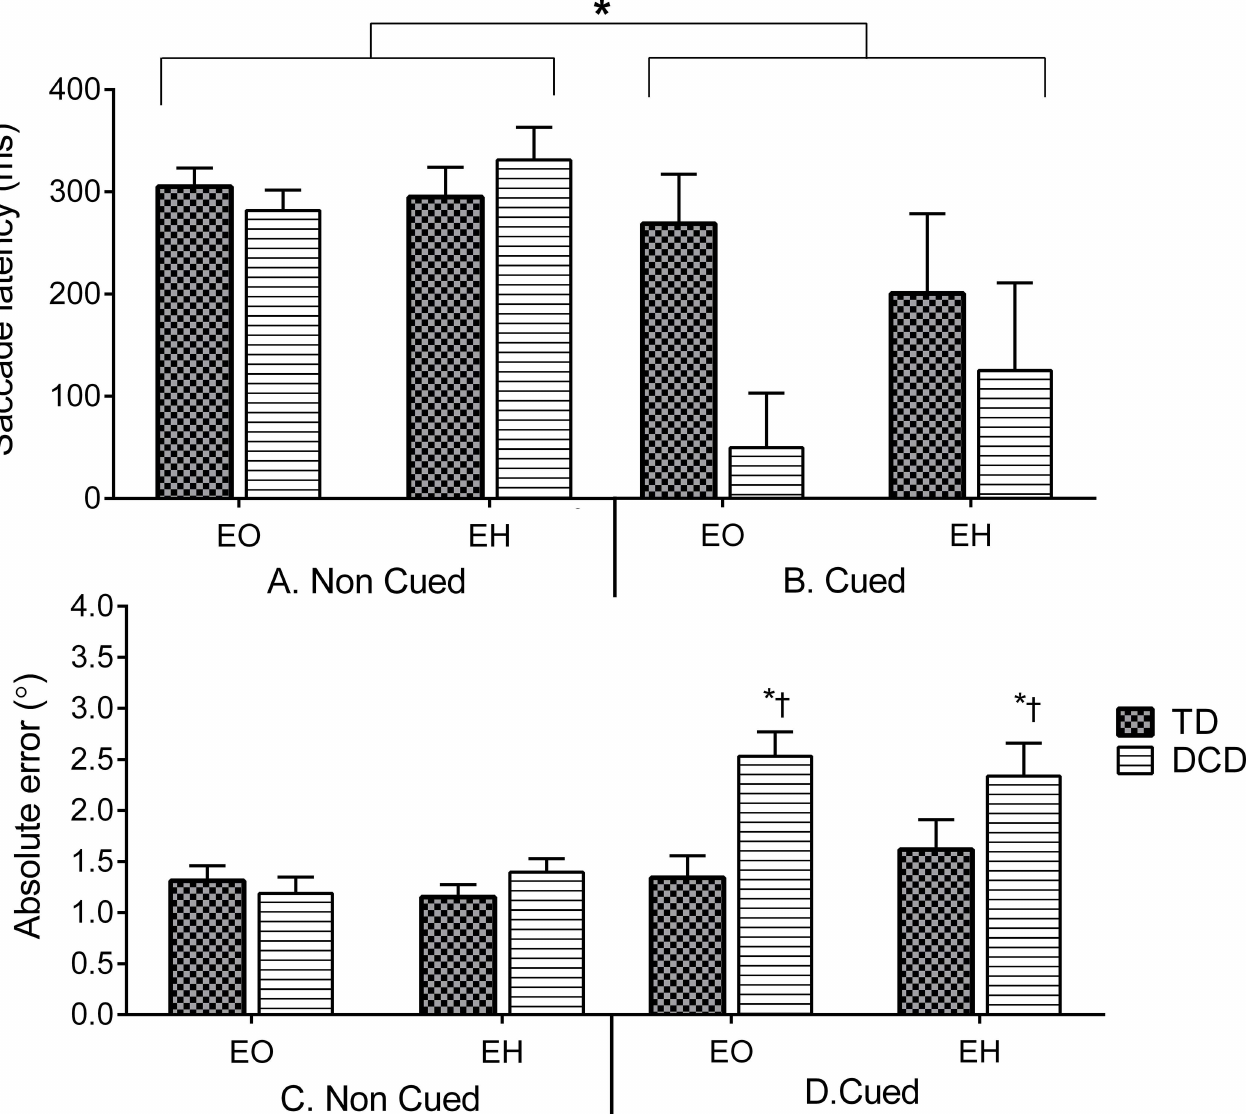
Fig 4. Mean (and SEM) Non-Cued(A) and Cued (B) saccade latenciesacross eye only (EO) and eye and hand (EH) tasks. Overall, the groups decreasedsaccade latencies in Cued conditions(Cued vs. Non-Cued, * ). Lower panel. Mean Non-Cued(C) and Cued (D) saccade accuracy (and SEM) across eye only (EO) eye and hand (EH) tasks. Children with DCD (striped columns) exhibitedincreasedabsolute errors in the Cued conditionscompared to the TD children (dark grey, D) and compared to the Non-Cued conditions(group by cue conditioninteraction, * †). However, there were no accuracy or latency differences between the groups in the Non-Cuedconditions